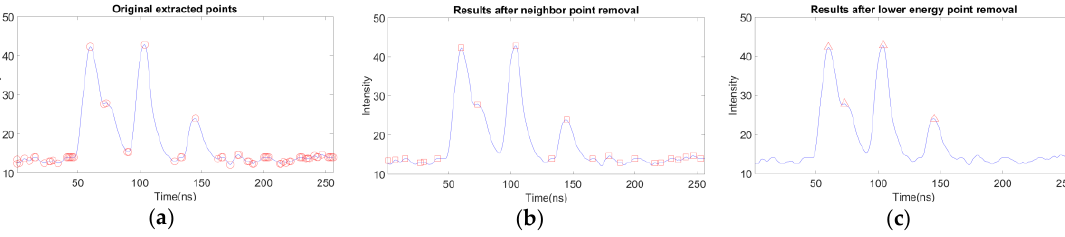
Figure 1. The illustration of initial peaks’ detection: ( a ) Original extracted points; ( b ) Results after neighbor point removal; ( b ) Results after lower energy point removal.